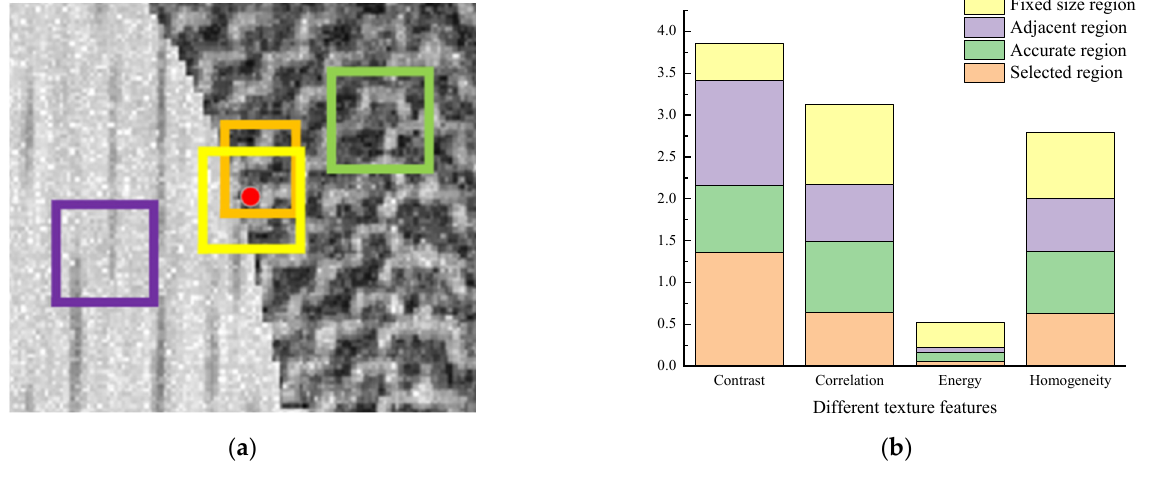
Figure 13. ( a ) Different regions for texture feature extraction and ( b ) the value of different texture features extracted in different regions.